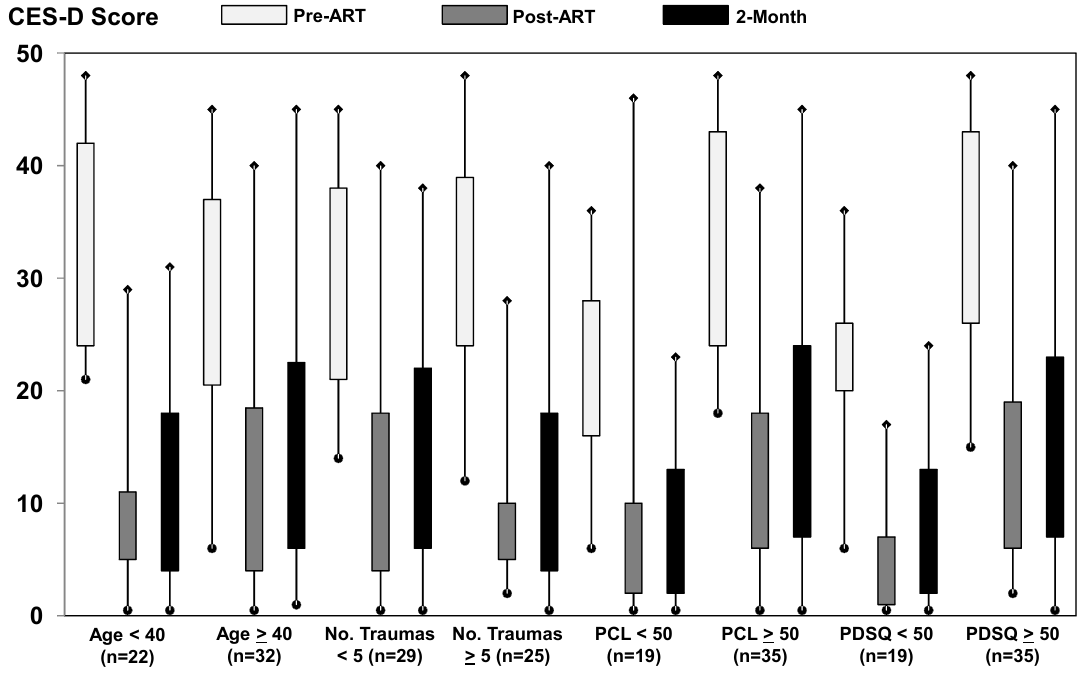
Figure 3. Distribution of self-report scores on the CES-D among subgroups at baseline, post-treatment, and 2-month follow-up. The rectangles depict the interquartile range; the lower and upper ends of the vertical lines with the diamonds depict the 5th and 95th percentiles,